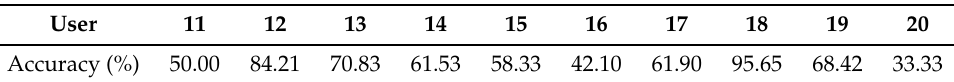
Table 10. Test with 20 users—Part